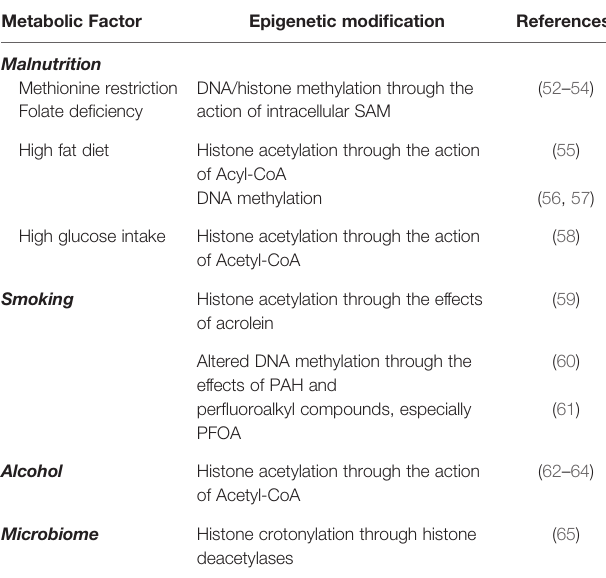
TABLE 1 | Factors listed as examples of stressors in the presented hypothesis and the mechanisms by which they alter the